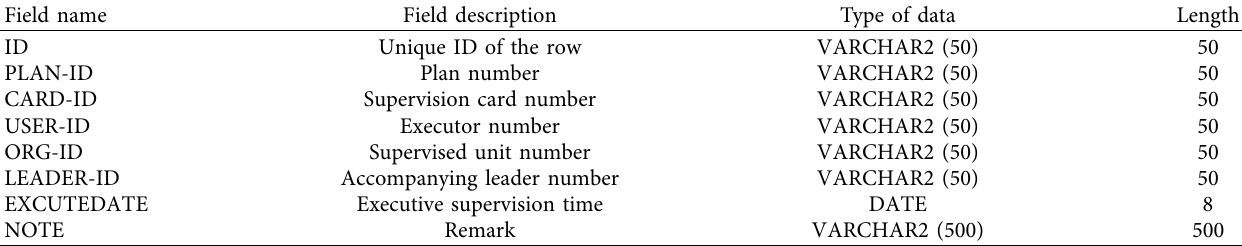
Table 2: Monitoring task data dictionary.